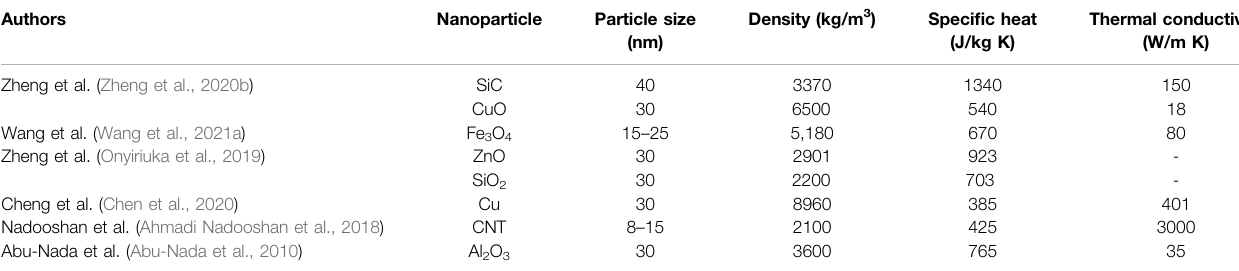
TABLE 1 | Physical properties of various nanoparticles.